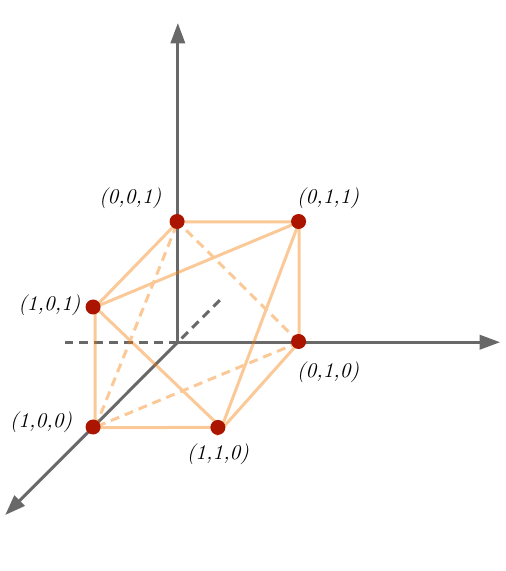
Figure 7 . The toric fan of Q 111 in the w